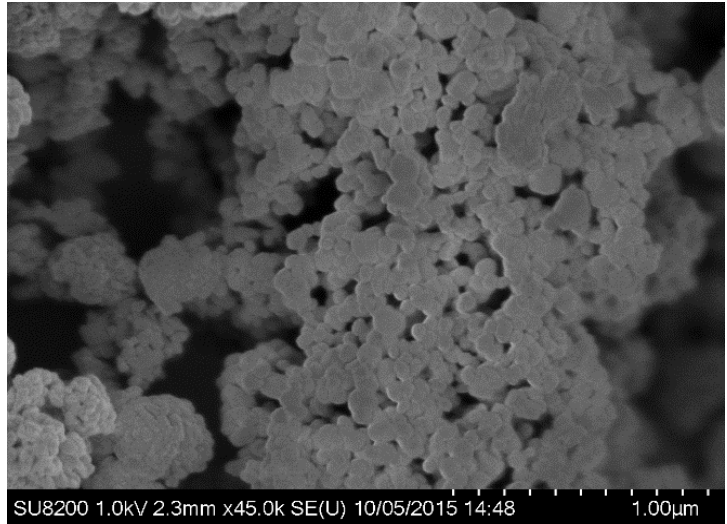
Figure 6. Scanning electron microscopy (SEM) image of engineered CuO nanoparticles.